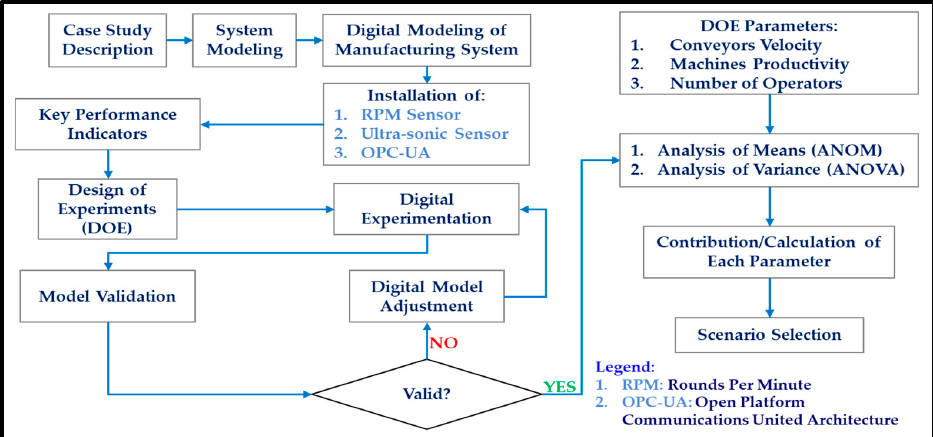
Figure 6. Work fl ow of the Proposed Methodology. Figure 6. Workflow of the Proposed